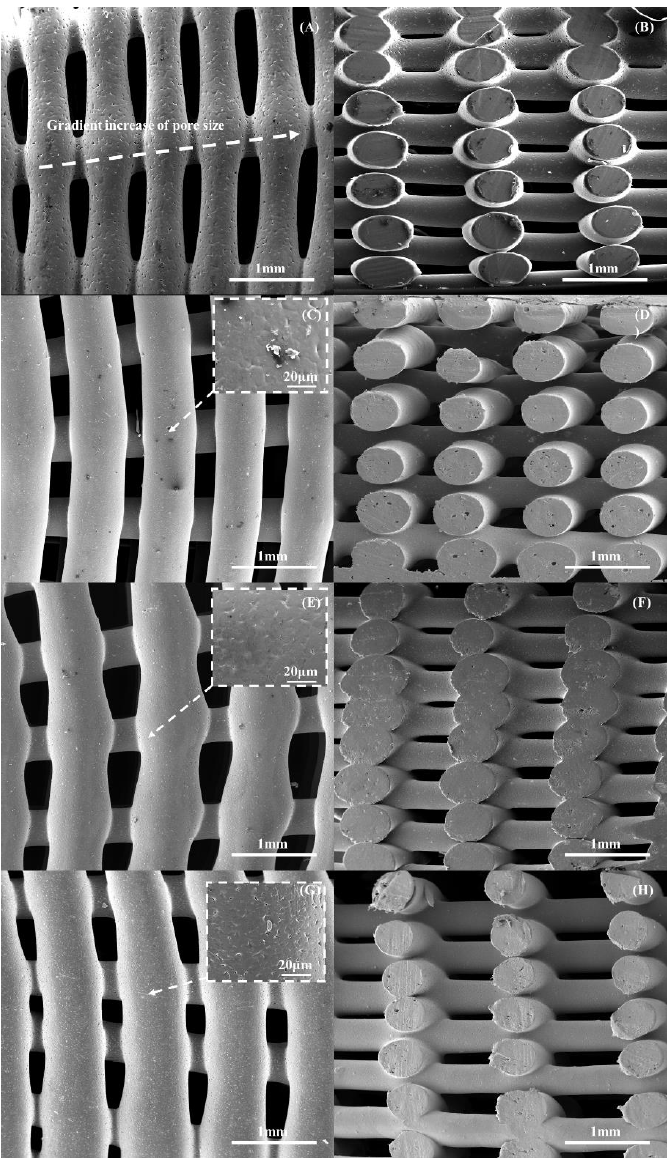
Figure 5. The top and cross-section SEM images of the scaffolds with different material compositions: ( A , B ) PCL; ( C , D ) bioglass 10 wt%; ( E , F ) bioglass 15 wt%; and ( G , H ) bioglass 20 wt%.